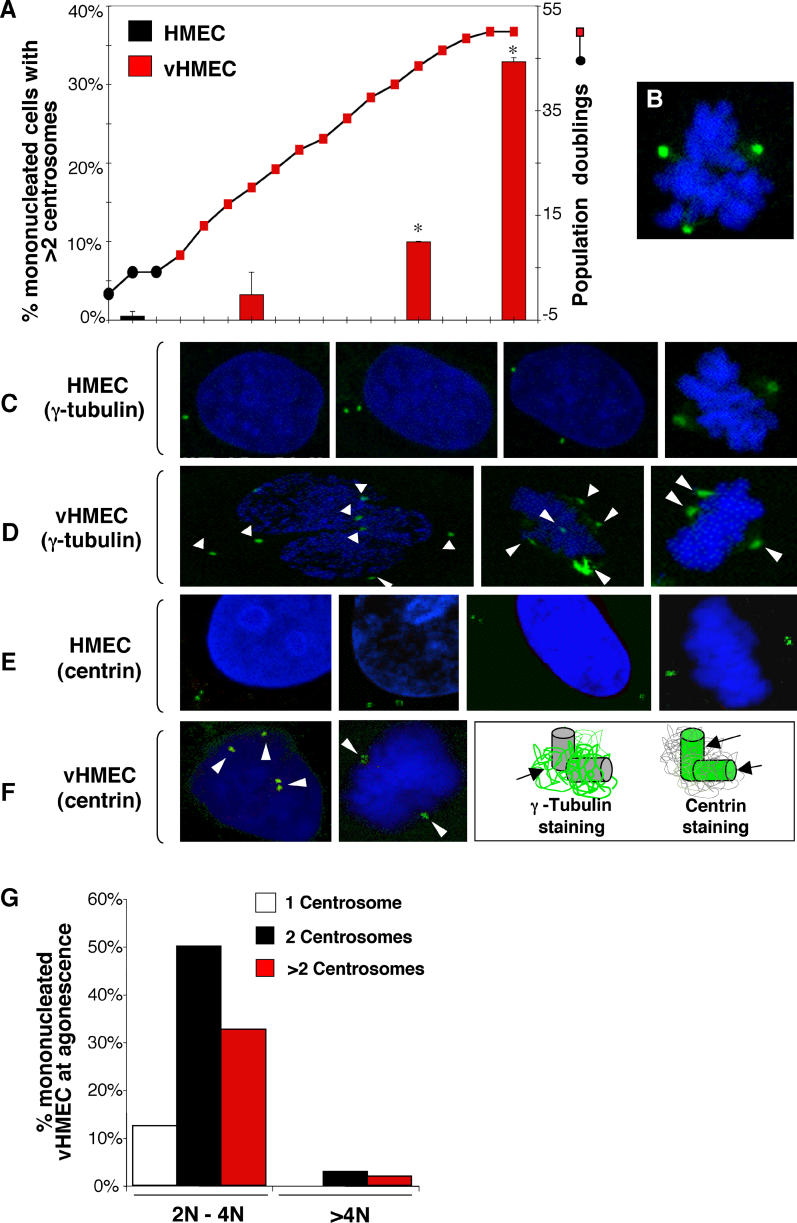
vHMECs Accumulate Mitotic and Centrosome Abnormalities(A) The solid line graph represents the in vitro growth curves of both HMECs (black circles) and vHMECs (red squares) isolated from RM16. The bar graph represents analysis of mononucleated cells containing more than two centrosomes. Centrosome number was determined by immunocytochemistry with an antibody recognizing the centrosome-associated γ-tubulin protein (excluding multinucleated cells). Cells were analyzed at multiple points along the growth curves of two different individuals (RM9 and RM16). HMEC (black) (RM9 and RM16 [less than five PD]) and vHMECs (red) analyzed at early-passage (RM9 [14 PD] and RM16 [20 PD]), late-passage (RM9 [43 PD], RM9 [65 PD]), and the agonescence (RM9 [70 PD] and RM16 [50 PD]). *Statistical significance (p < 0.005) based on comparison of HMECs to vHMECs.(B) Example of a late-passage vHMEC with a tripolar mitotic metaphase. Examples of centrosomes of HMECs (C and E) and vHMECs (D and F) detected by immunocytochemistry with antibodies recognizing the centrosome-associated γ-tubulin (C and D) and centrin (E and F) proteins. Examples of HMECs representing normal centrosomes during the G1 phase of the cell cycle (C and E, first panel), during the S and G2 phases of the cell cycle (C and E, second panel), during the M phase with centrosomes migrating to opposite poles of the cell (C and E, third and fourth panels), and vHMECs containing cells with more than two centrosomes (D and F, arrowhead).(G) Agonescent vHMECs (RM16 [47 and 50 PD]) were stained with an antibody recognizing γ-tubulin and with PI (DNA counterstain), and the DNA content of each nucleus was measured by quantitative immunofluorescence microscopy. Cells were classified as having 2N to 4N (diploid) or more than 4N (polyploidy) DNA content. The centrosome number (γ-tubulin signal) of each cell was linked to that individual nucleus. Analysis included 150 to 250 cells.